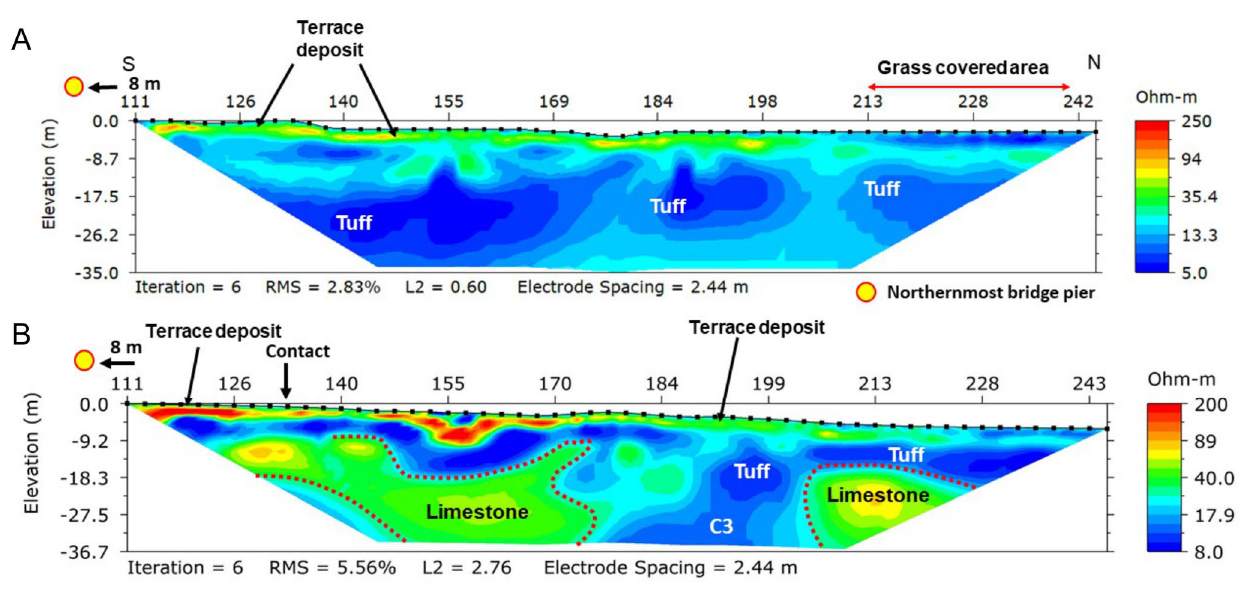
Figure 8: Resistivity data obtained along profiles P3 [A] and P4 [B] on the west and east side of the railroad track, respectively. Note that resistivity profiles are separated by 25 m, yet they o ff er di ff erent geoelectric sections